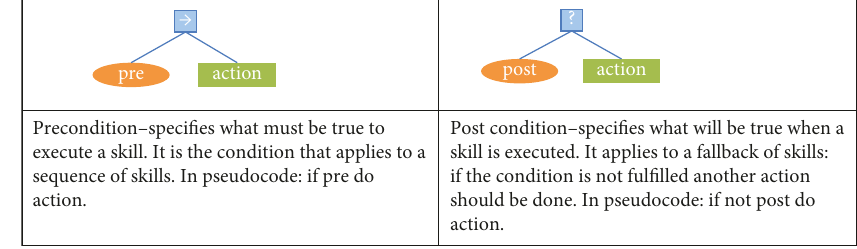
Figure 5: Pre- and post-condition defined.